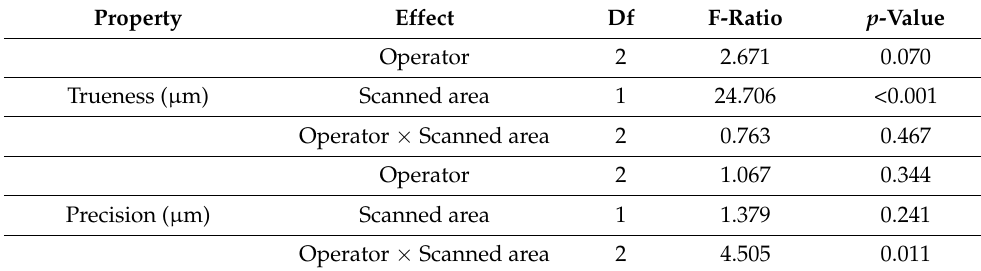
Table 1. Two-way ANOVA results for trueness and precision.